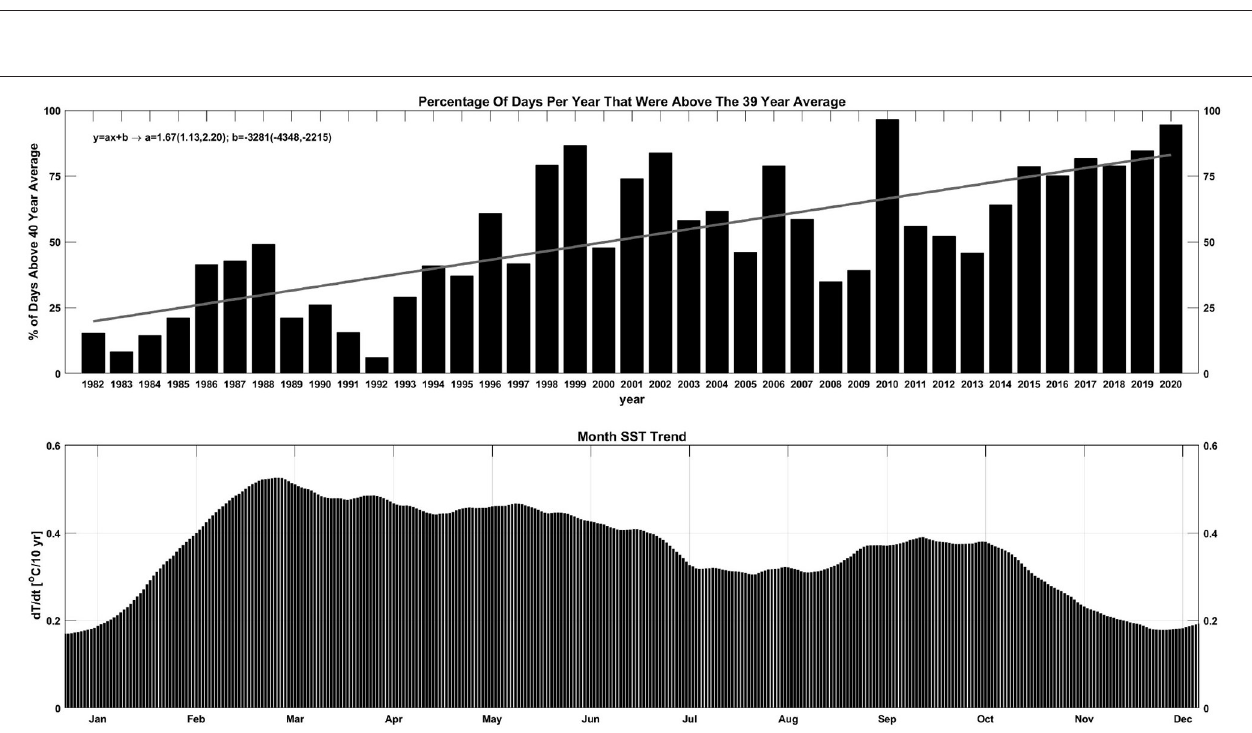
FIGURE 8 | (Top): Time series of percentage of days within each year above 39-year period average for 1982–2020; (Bottom map) rate of warming per decade for each day of year.